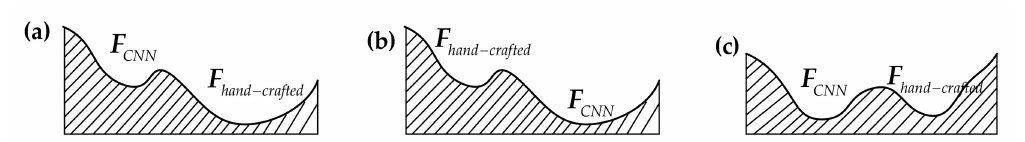
Figure 15. Diagrammatic sketch of the huge feature dimension imbalance. ( a ) the feature dimension of F hand-crafted is far larger than that of F CNN , i.e., Case 1; ( b ) the feature dimension of F CNN is far larger than that of F hand-crafted , i.e., Case 2; ( c ) a balanced feature dimension, i.e., Case 3 of the DU-Cat. Here, the x-axis represents the optimization direction, and the y-axis represents the feature dimension.